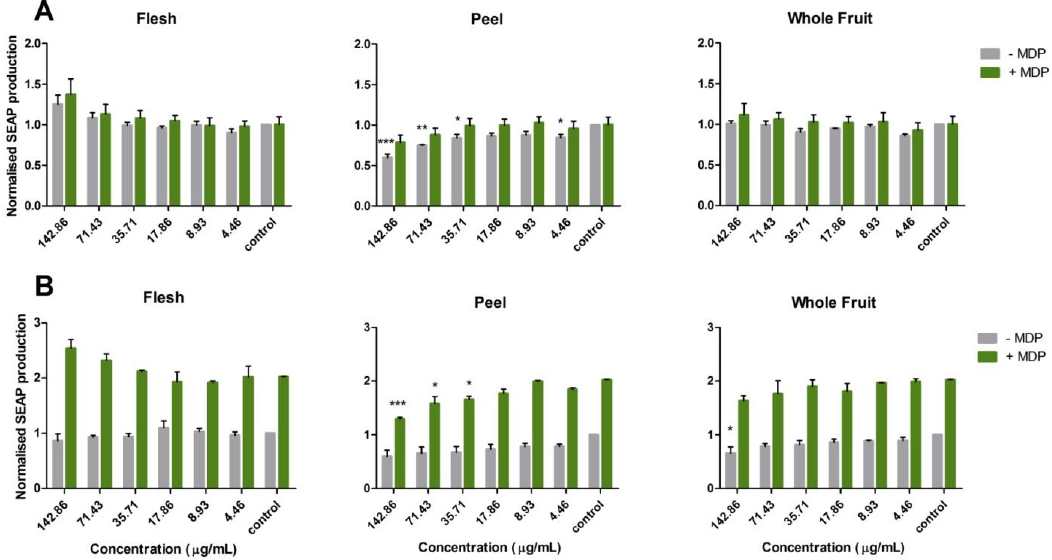
Figure 3. Anti-inflammatory activity of feijoa extracts on the ( A ) NOD2-G908R and ( B ) NOD2-WT cell lines. Cells were treated with feijoa flesh, peel and whole fruit extracts from APOLLO cultivars. Muramyl dipeptide (MDP) ligand was used to stimulate an inflammatory response through the NOD2 pathway. A normalized SEAP production lower than in the control indicates a potential anti-inflammatory effect. Statistical analysis was carried out using one-way analysis of variance (ANOVA) (*** p < 0.001, ** p < 0.01, * p < 0.05). It is interesting to note that the feijoa flesh, peel and whole fruit extracts (APOLLO cultivar) did not show the same pattern of effect on the SEAP expression induced by MDP stimulation. Flesh